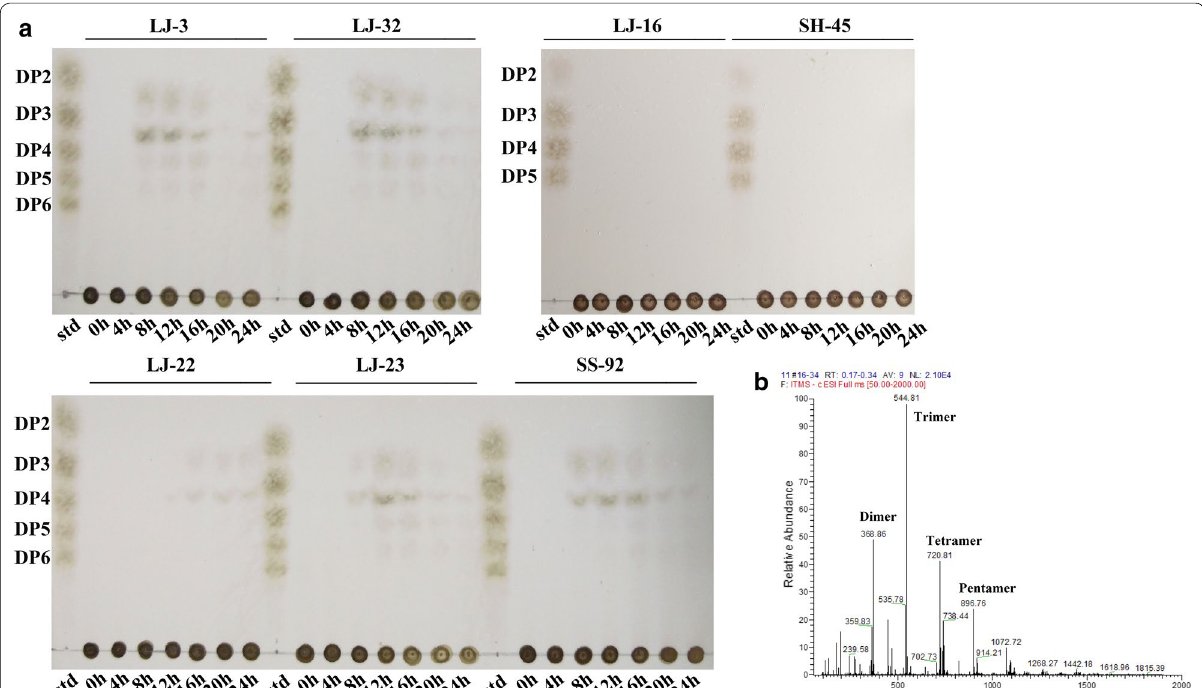
Fig. 5 Thin layer chromatography (TLC) analysis of degrees of polymerization of the alginate oligosaccharides. Aliquot samples were taken at the interval of 4 h and then spotted on the TLC plate. Std alginate oligosaccharide standards. DP2–DP6 the mannuronic acid sodium salt dimer,